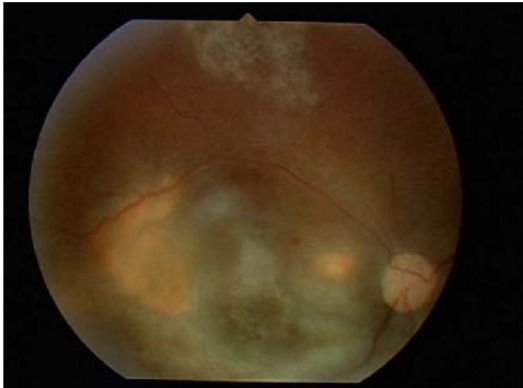
Figure 3 Active Toxoplasma chorioretinitis (Photo courtesy of Dr Linda Visser) Fungal